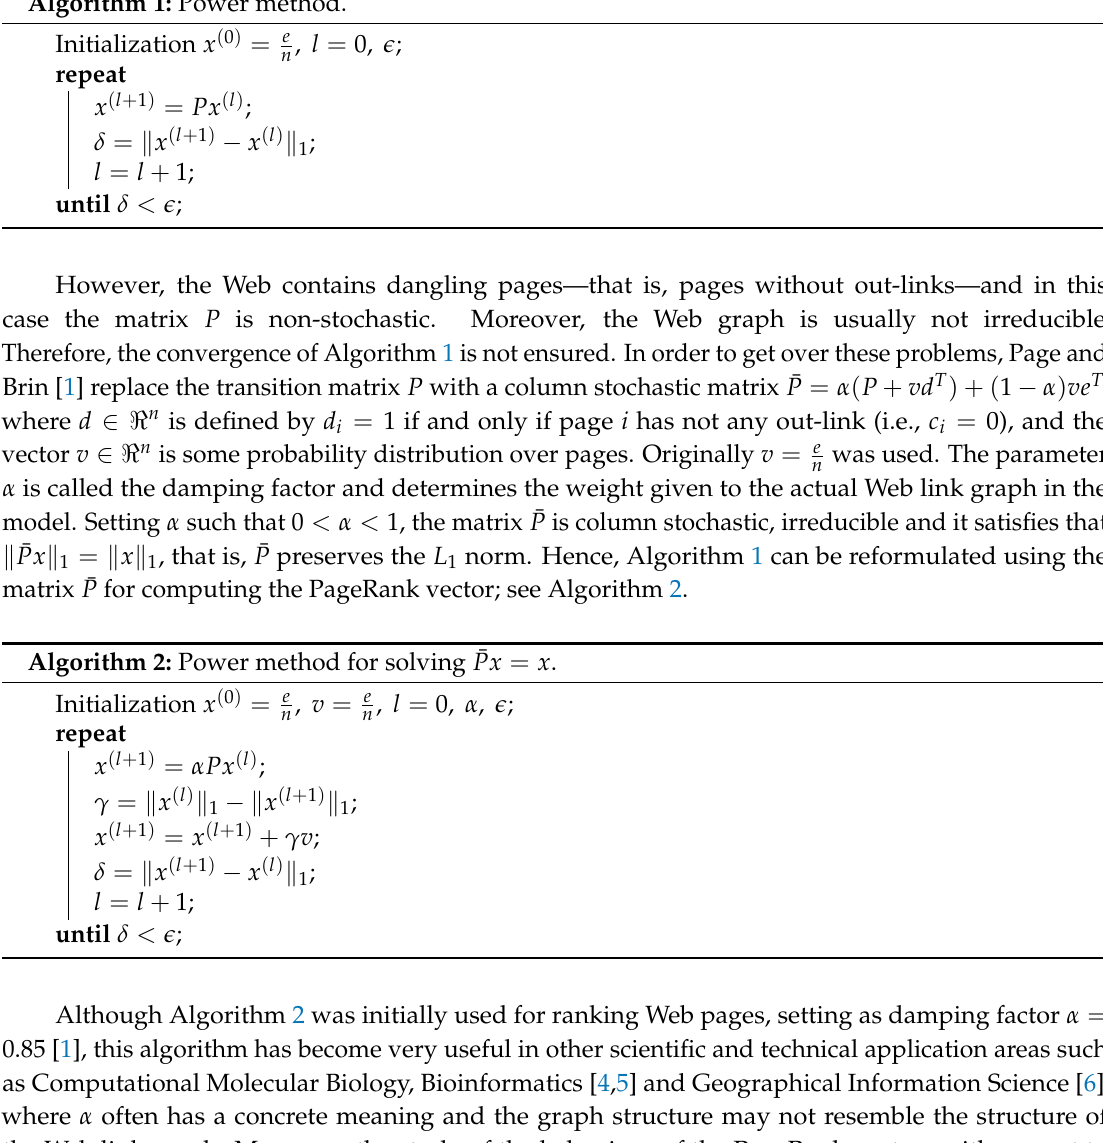
Algorithm 1: Power method.